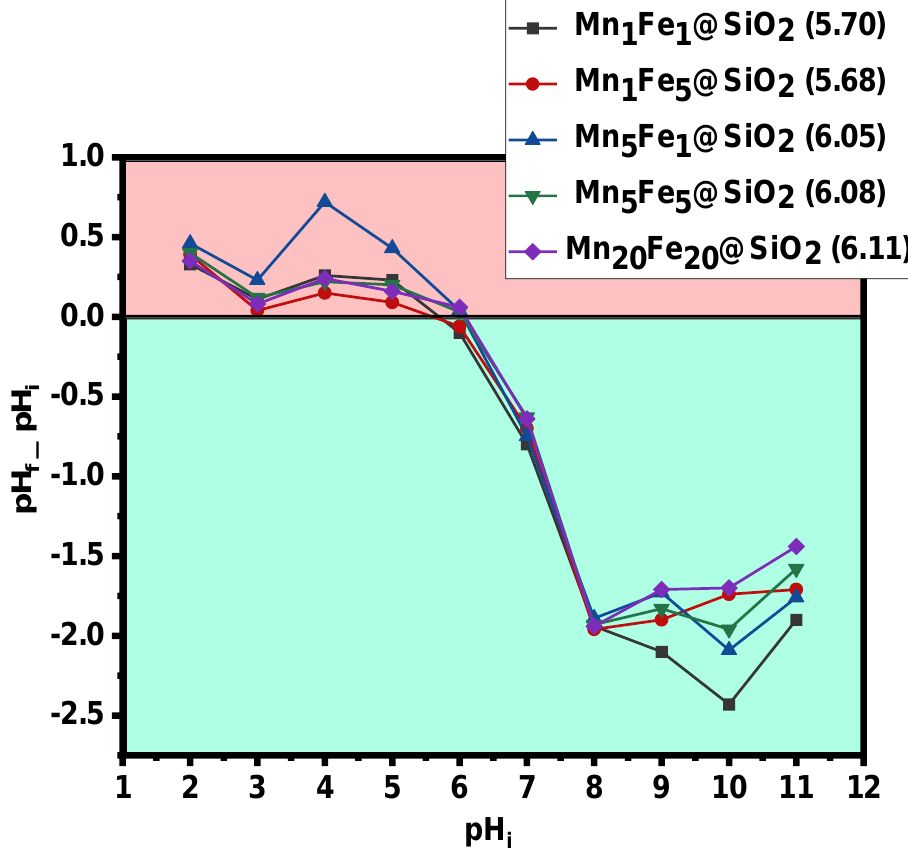
Figure 11. Zeta potential of used nanocomposites in this study.